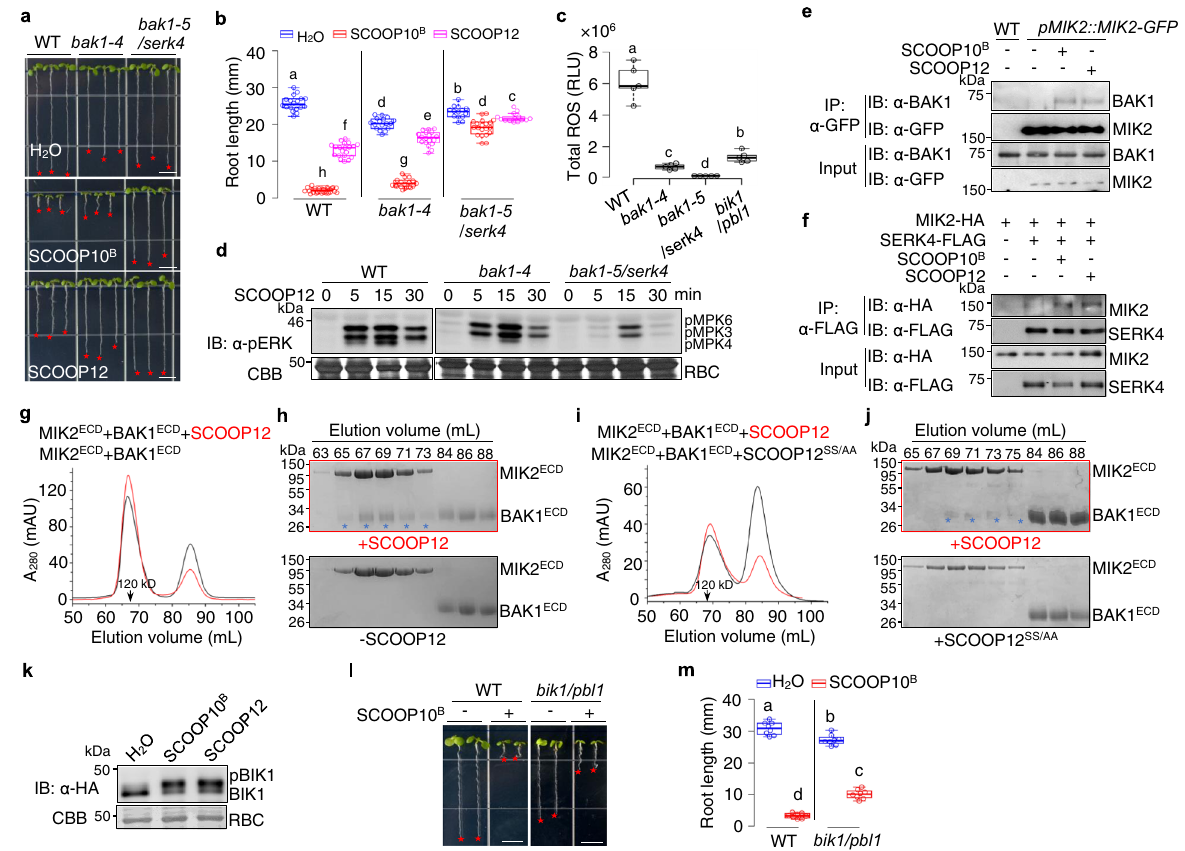
Fig. 5 SCOOPs induce MIK2-BAK1/SERK4 complex formation and relay signaling through BIK1 and PBL1. a , b SCOOP-triggered root growth inhibition is compromised in bak1-4 and bak1-5/serk4 . Images of 10-day-old seedlings with or without 1 µ M SCOOP10 B or SCOOP12. Scale bar, 4 mm ( a ). Quanti fi cation of root length ( b ). c SCOOP12-induced ROS is compromised in bak1-4 , bak1-5/serk4 , and bik1 / pbl1 . One-week-old seedlings were treated with 100 nM SCOOP12, and ROS production was calculated as total RLUs. d SCOOP12-induced MAPK activation is compromised in bak1-4 and bak1-5/serk4 . The assay was done as in Fig. 3g. e SCOOPs induce MIK2-BAK1 association. Leaves of pMIK2::MIK2-GFP / mik2-1 plants were treated with or without 1 μ M SCOOPs for 30 min. Total proteins were subjected for immunoprecipitation (IP) with α -GFP agarose beads, and the immunoprecipitated proteins were detected with α - BAK1 or α -GFP antibodies (top two). The input controls before IP are shown on the bottom two panels. f SCOOPs induce MIK2-SERK4 association. Protoplasts expressing MIK2-HA and SERK4-FLAG, or a control vector (Ctrl) were treated with or without 1 μ M SCOOPs for 15 min. IP and IB were performed as ( e ). g , h SCOOP12 induces MIK2 ECD -BAK1 ECD interaction. Gel fi ltration chromatography analysis using MIK2 ECD and BAK1 ECD shows the elution pro fi les in the presence (red) or absence (black) of 0.1 mg SCOOP12 ( g ). SDS-PAGE and CBB staining show the eluted fractions (top panel with SCOOP12; bottom panel without SCOOP12). Stars indicate the eluted BAK1 ECD complexing with MIK2 ECD ( h ). i , j SCOOP12 SS/AA does not induce MIK2 ECD -BAK1 ECD interaction. Experiments were performed as in ( g ) and ( h ). k SCOOPs induce BIK1 phosphorylation. Protoplasts expressing BIK1-HA were treated with 1 μ M SCOOP10 B or SCOOP12 for 15 min. Proteins were subjected to IB using α -HA antibodies (top), and CBB staining for RBC as loading controls (bottom). Phosphorylated BIK1 (pBIK1) was indicated as a band mobility shift. l , m SCOOP10 B -triggered root growth inhibition is compromised in bik1/pbl1 . Images of 10-day-old seedlings with or without 1 µ M SCOOP10 B . Scale bar, 4 mm ( l ). Quanti fi cation of root length ( m ). The box plots in ( b ), ( c ), and ( m ) show the fi rst and third quartiles as bounds of box, split by the medians (lines), with whiskers extending 1.5-fold interquartile range beyond the box, and minima and maxima as error bar. A signi fi cant difference is shown between different letters ( P < 0.05, one-way ANOVA followed by Tukey ’ s test, n = 15, b , 5, c , and 8, m ). Experiments in ( a – d ), ( l ), and ( m ) were repeated three times and ( e – k ) twice with similar